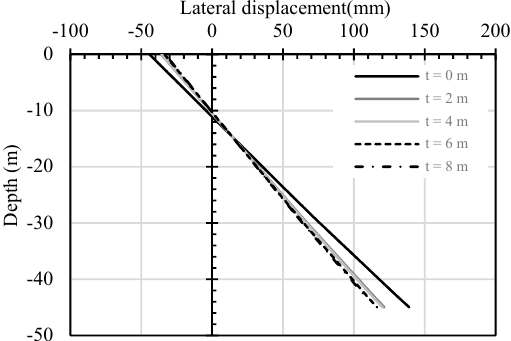
Figure 12. The variation curve of lateral displacement along the depth of a caisson with different reinforcement thicknesses.